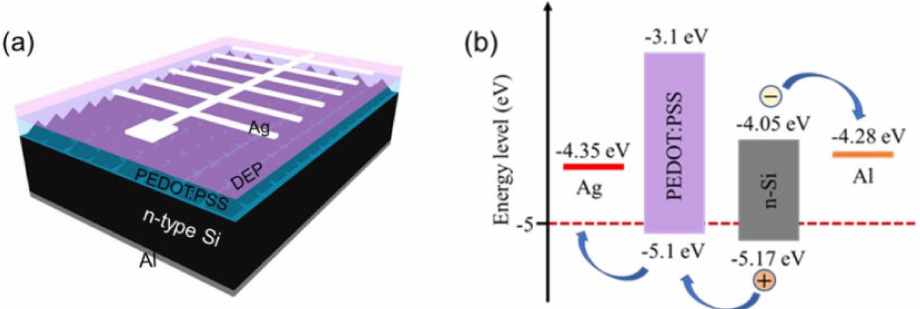
Figure 1. ( a ) Structure diagram of the Si-PNWs/PEDOT:PSS solar cells with DEP coating. ( b ) Energy band diagrams of the Si-PNWs/PEDOT:PSS solar cells.